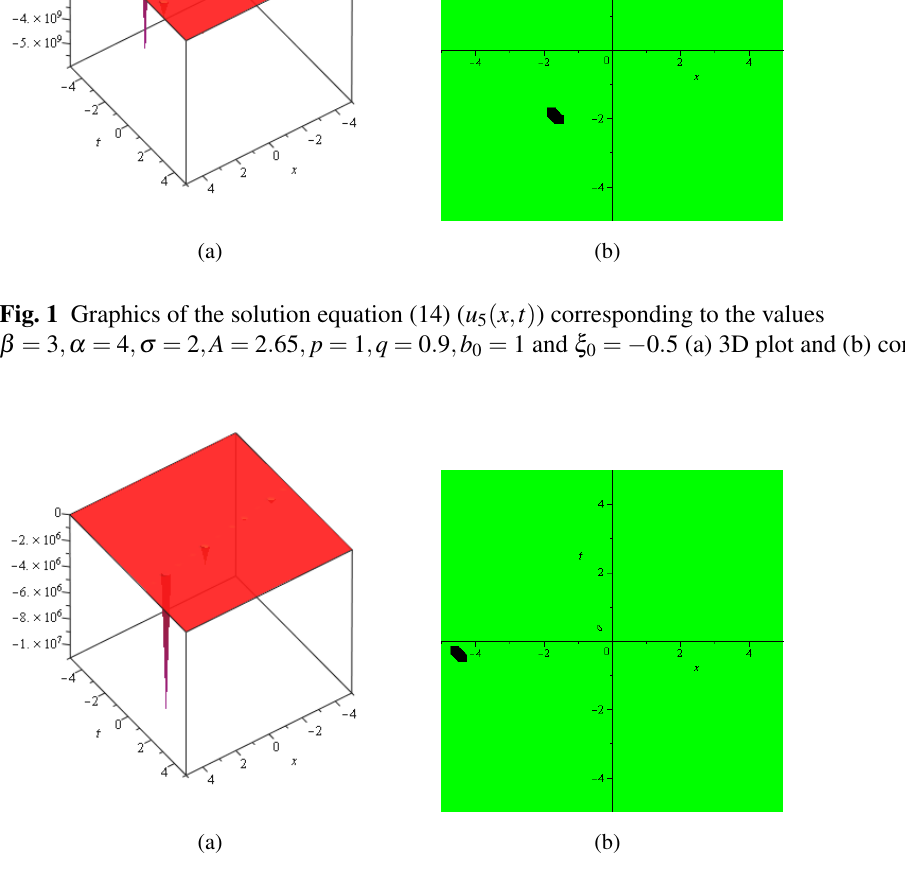
Fig. 2 Graphics of the solution equation (28) ( u 14 ( x , t ) ) corresponding to the values λ = 1 . 5 , m = 3 , A = 2 . 7 , p = 1 . 2 , q = 0 . 9 , b 0 = 3 and ξ 0 = 1 . 5 (a) 3D plot and (b) contour